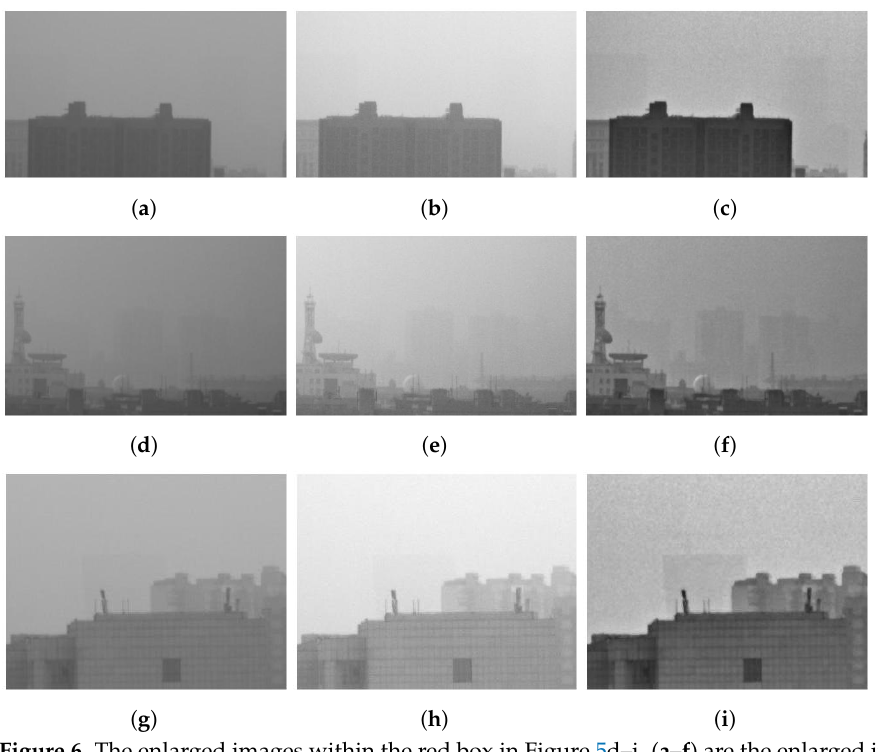
Figure 6. The enlarged images within the red box in Figure 5d–i. ( a – f ) are the enlarged images cut from Figure 5d–f, respectively; ( g – i ) are the enlarged images cut from Figure 5g–i, respectively. Gray Level Histogram